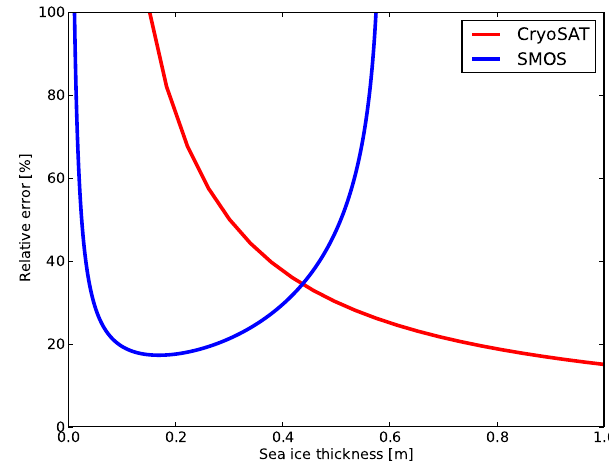
Fig. 8. Error characteristic of SMOS and CryoSat ice thickness retrieval for a simplified error budget as explained in the